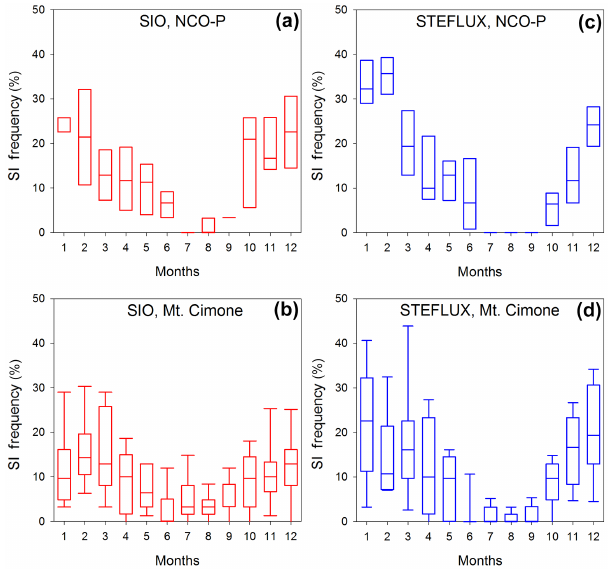
Figure 3. Box-and-whisker plot of the annual variation in SI fre- quency at NCO-P (a, c) and Mt. Cimone (b, d) . For both sites, the SIO (a, b) and STEFLUX (c, d) values are